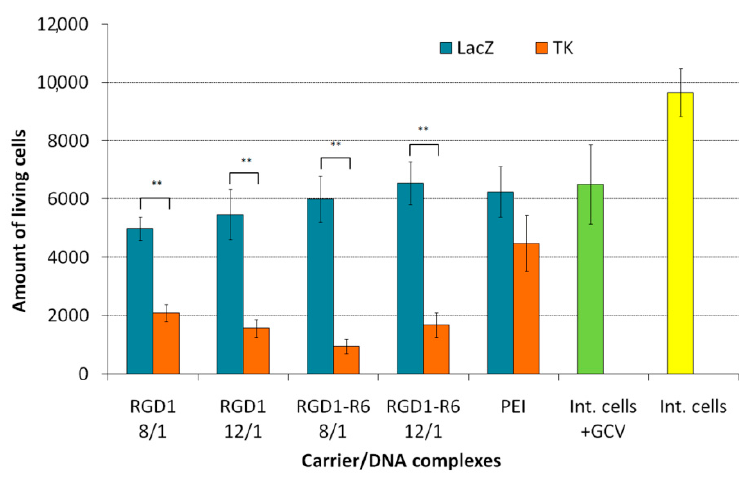
Figure 9. Amount of living UL cells after HSV thymidine kinase expression and GCV treatment. Values are the mean ± SD of the mean of triplicates. ** p < 0.01 compared to pCMV-lacZ-complexes. Similarly, we registered a 3–4-fold decrease in the PANC-1 cells proliferative activity after pPTK plasmid delivery with RGD1-R6 carrier (Figure S3). For comparison, non-cross-linked RGD1/pPTK polyplexes decreased PANC-1 cells viability only 1.25–1.6-fold [42]. We also observed that the anti-proliferative efficacy of RGD1-R6-based polyplexes was higher than that of PEI/DNA complexes (1.7-fold decrease). The relative number of living cells after suicide gene therapy with RGD1-R6/pPTK polyplexes was reduced by 70% compared to their initial number which was greater than the transfection efficiency (22–28% of PANC-1 cells transfected) (Figure